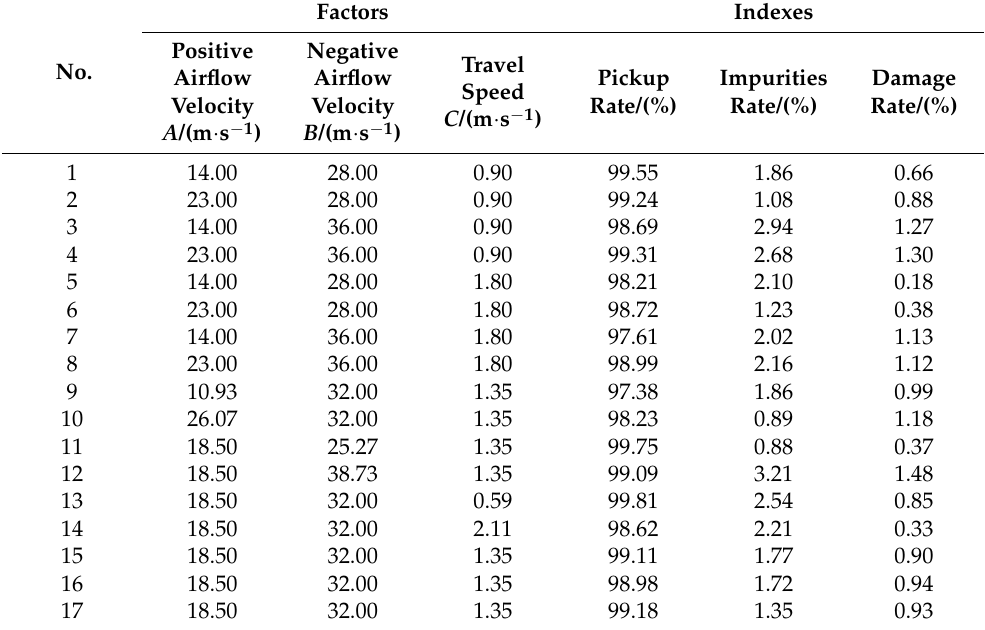
According to the experiment factors and level values in Table 3, the pickup rate, impurities rate, and damage rate were taken as response indexes. The central composite design method of design expert 10.0.3 software was used to design the three-factor and five-level central composite experiment scheme [30,31]. A total of twenty test groups that included five groups zero estimation errors and fifteen groups physical prototype tests were carried out, according to the experiment scheme. The experimental schemes and results were shown in Table 4. The interval values of the pickup rate, impurities rate, and damage rate were 97.38~99.81%, 0.88~3.21%, and 0.18~1.48%, respectively. Table 4. Experimental factors and indexes.